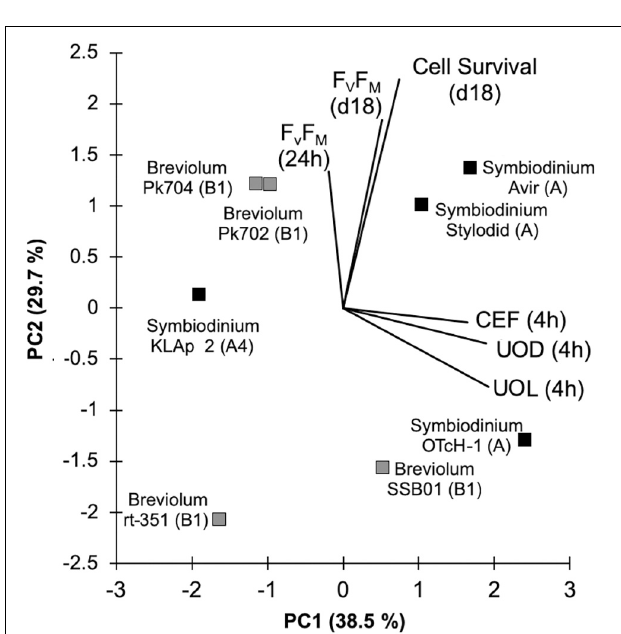
FIGURE 6 | Principal component analysis (PCA) plot showing the grouping of cultured Symbiodinium (black squares) and Breviolum spp. (gray squares) based on the main photosynthetic and physiological traits. Black lines indicate the correlation of the different parameters with PC1 and PC2.